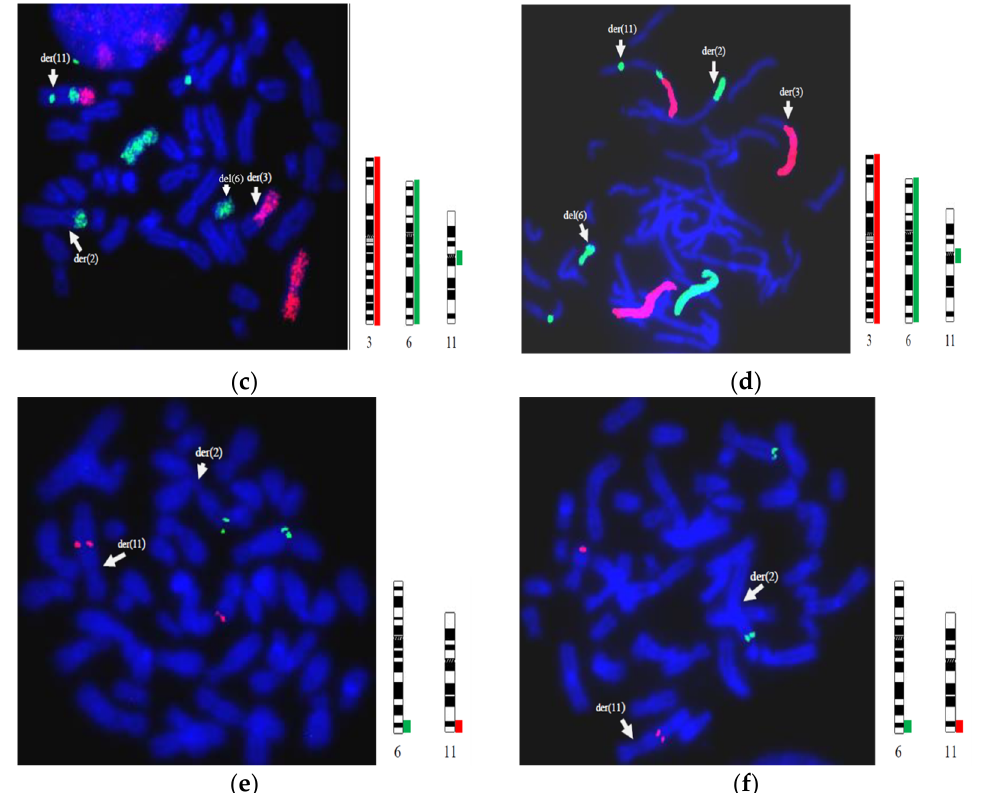
Figure 3. Molecular cytogenetic analysis of the chromosomal rearrangements. SKY using 24-color SKY probes showed similar complex chromosomal changes as G-banding in the child ( a ) and the mother ( b ). Four abnormal chromosomes, der(2), der(3), del(6) and der(11), were detected using WCP3-Texas Red, WCP6-FITC and CEP11-FITC probes by metaphase FISH; and der(11) contained partial fragments from chromosomes 3 and 6 in the child ( c ) and his mother ( d ). Metaphase FISH using telomere-specific probes, 6qter-FITC and 11qter-Texas Red, showed that the 11q telomere was intact and retained in the der(11) chromosome in the child ( e ) and the mother ( f ).